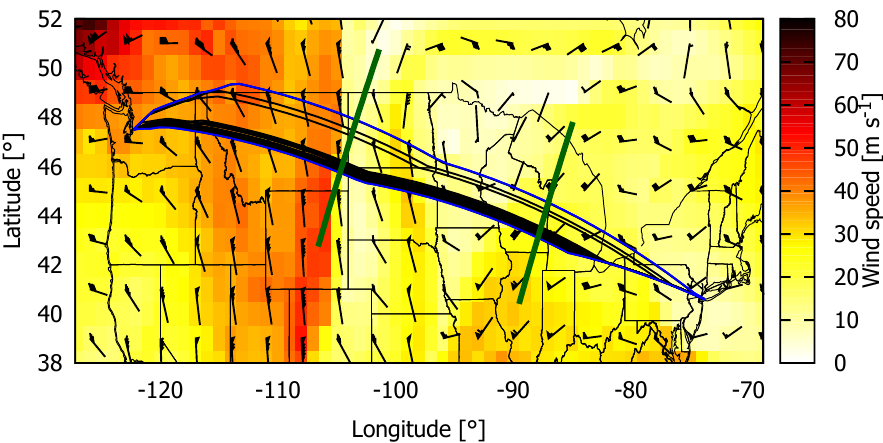
Figure 9. The set of 21 ensemble trajectories (black) for each ensemble forecast of 31 January 2020, Cycle 00, and the resulting CoO (blue). The heat map indicates wind speed with arrows for the wind direction (0–40 ms − 1 ) at the cruising altitude of approx. FL 370.